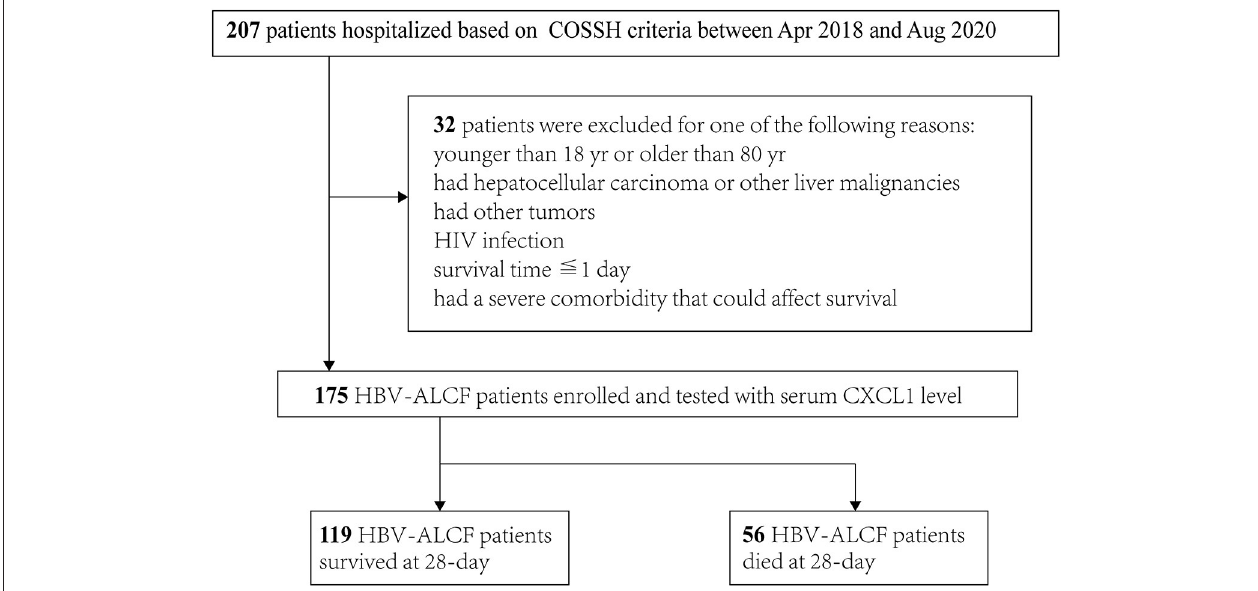
FIGURE 1 | Flowchart of the patient selection process. COSSH-ACLF score, Chinese Group on the Study of Severe Hepatitis B-ACLF; HIV, human immunodeficiency virus; HBV-ACLF, hepatitis B virus-related acute-on-chronic liver failure; CXCL1, C-X-C motif chemokine ligand